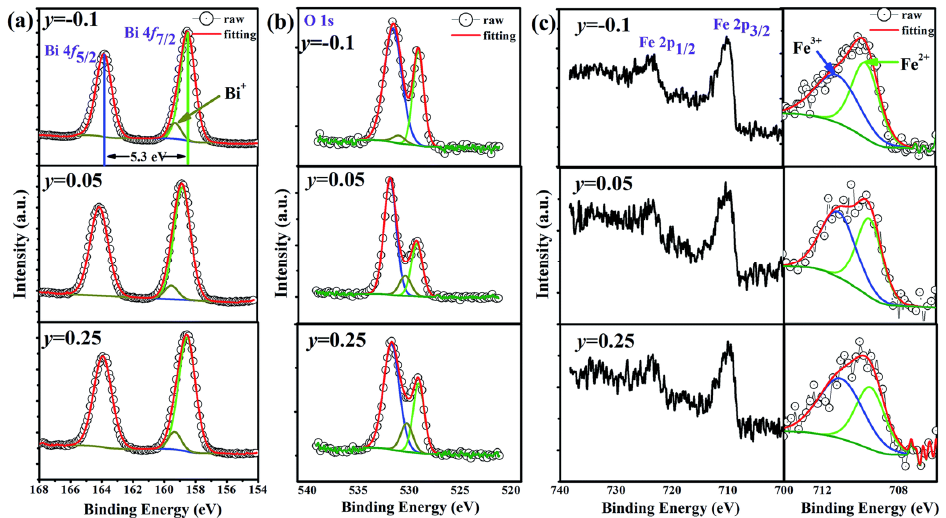
Figure 14. Valence states of the elements in (1− x )Bi 1+y FeO 3+3y/2 – x BaTiO 3 ceramics with y = −0.1, 0.05, and 0.25. ( a ) Bi 4f, ( b ) O 1s, and ( c ) Fe 2p. Reproduced from [126] with permission from the Royal Society of Chemistry.